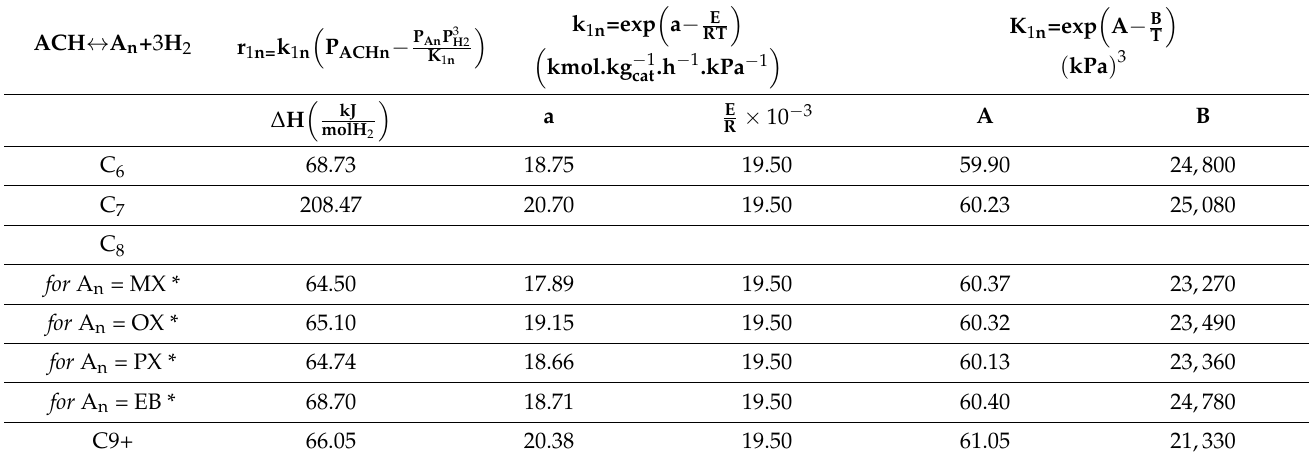
Table 1. Dehydrogenation reactions with the rate constant and heat of reaction